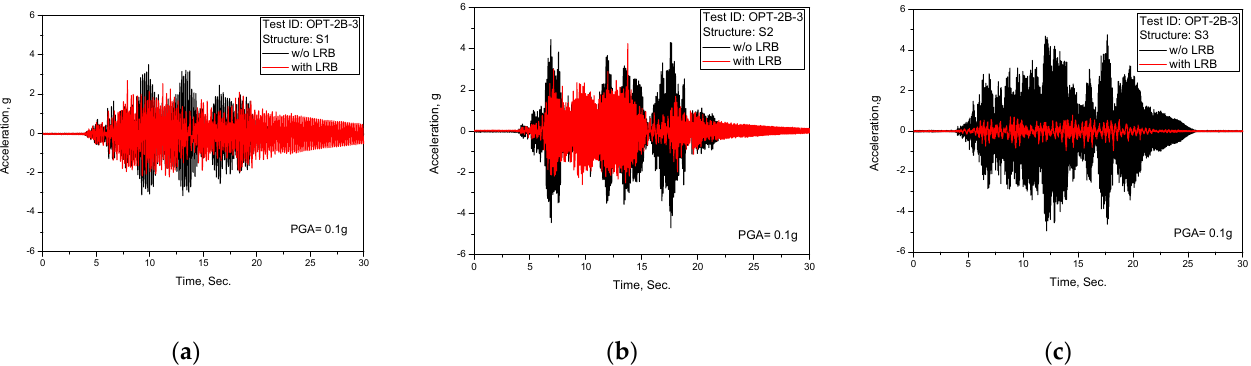
Figure 11. Test results of acceleration time history response (TEST ID: OPT-2B-3, PGA = 0.1 g): ( a ) S1; ( b ) S2; ( c ) S3.